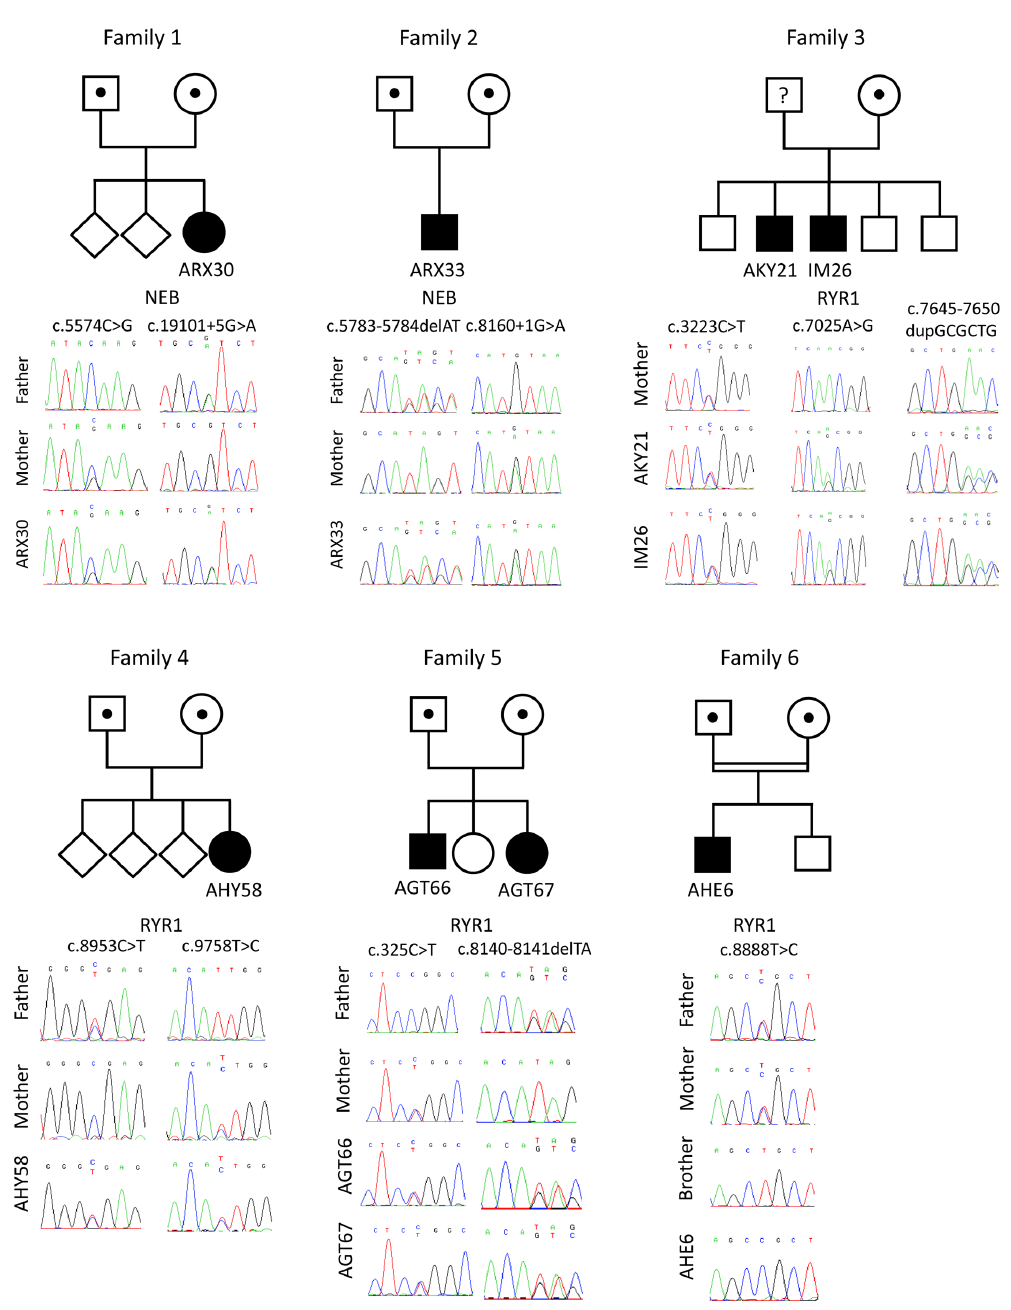
TPM3 , TNN1 , NEB , CFL2 , KBTBD13 ). Third, congenital myop-